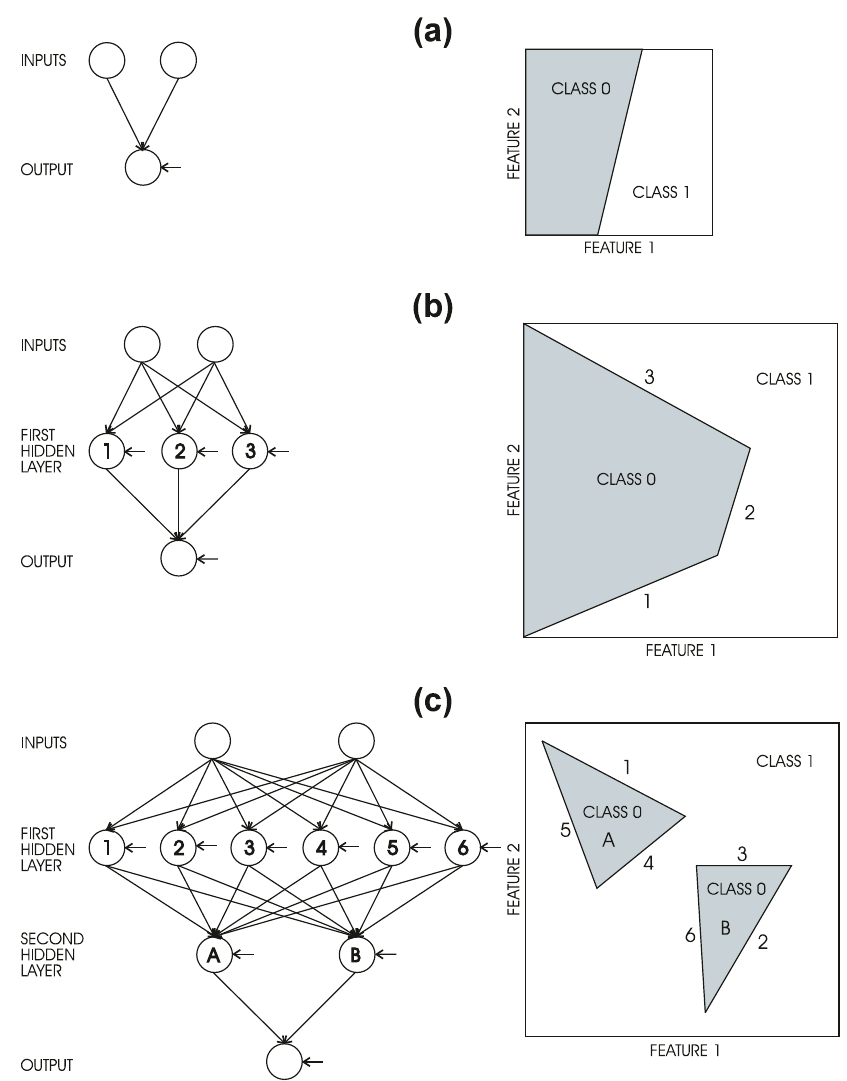
Fig. 3. Possible decision surfaces are shown for feed-forward networks with one, two and three layers of weights. In the first case (a) the decision surface will be a line and the network performs much like a linear discriminant function. When there are two layers of weights (b) the decision surface will be curved and can separate a single region of arbitrary shape. If more than two weight layers are used (c) the network can form boundaries around multimodal distributions in the feature